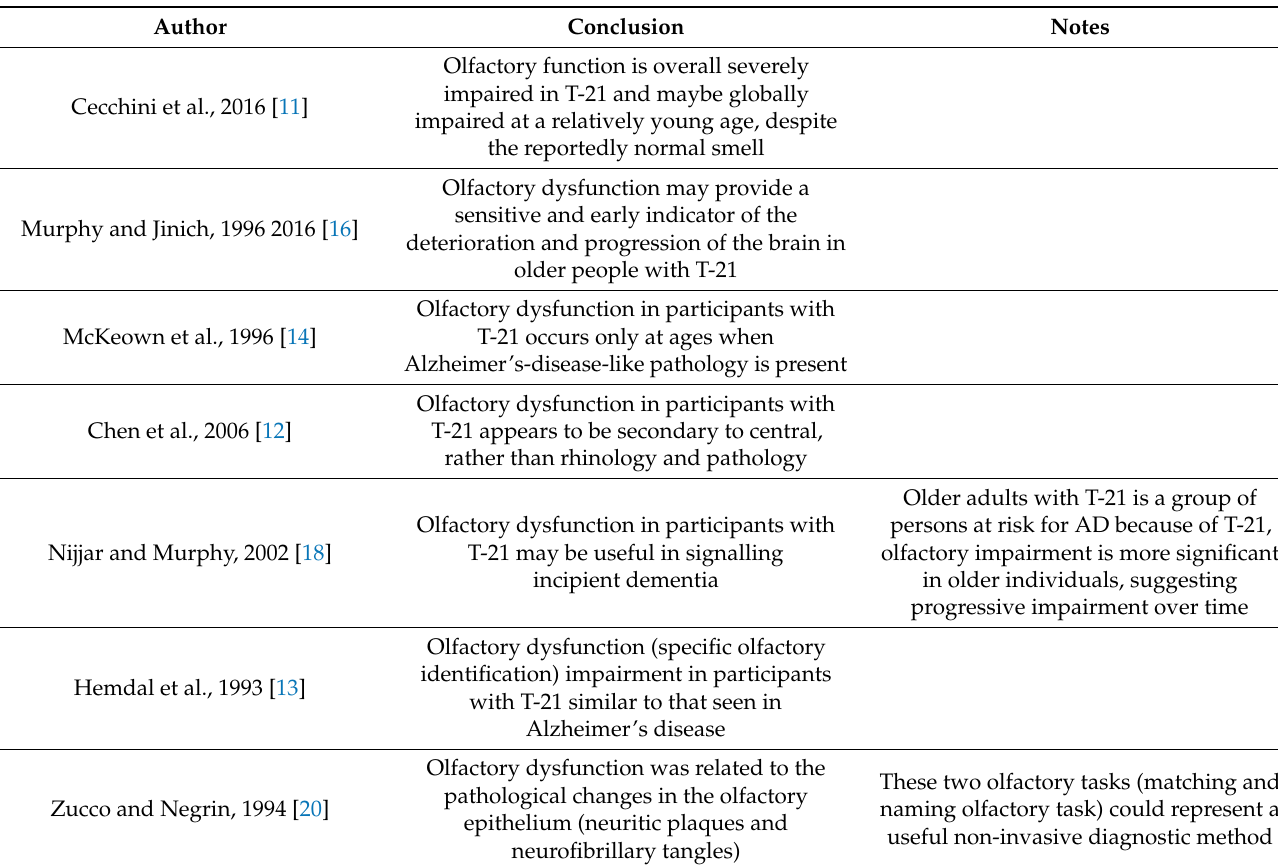
Table 4. Summary of the finding of olfactory dysfunction in an individual with trisomy 21 and the relation to Alzheimer ´ s